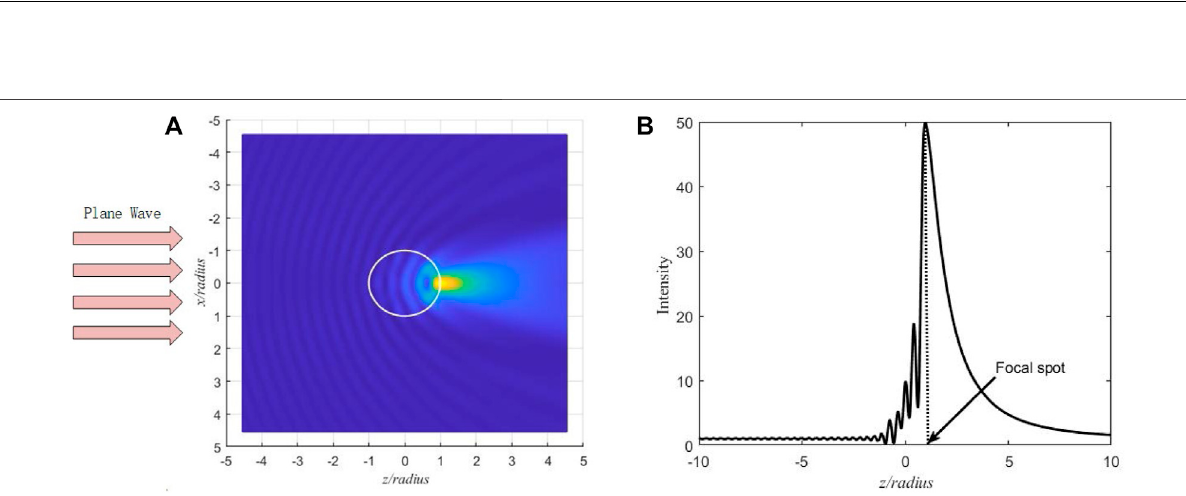
Frontiers in Physics |